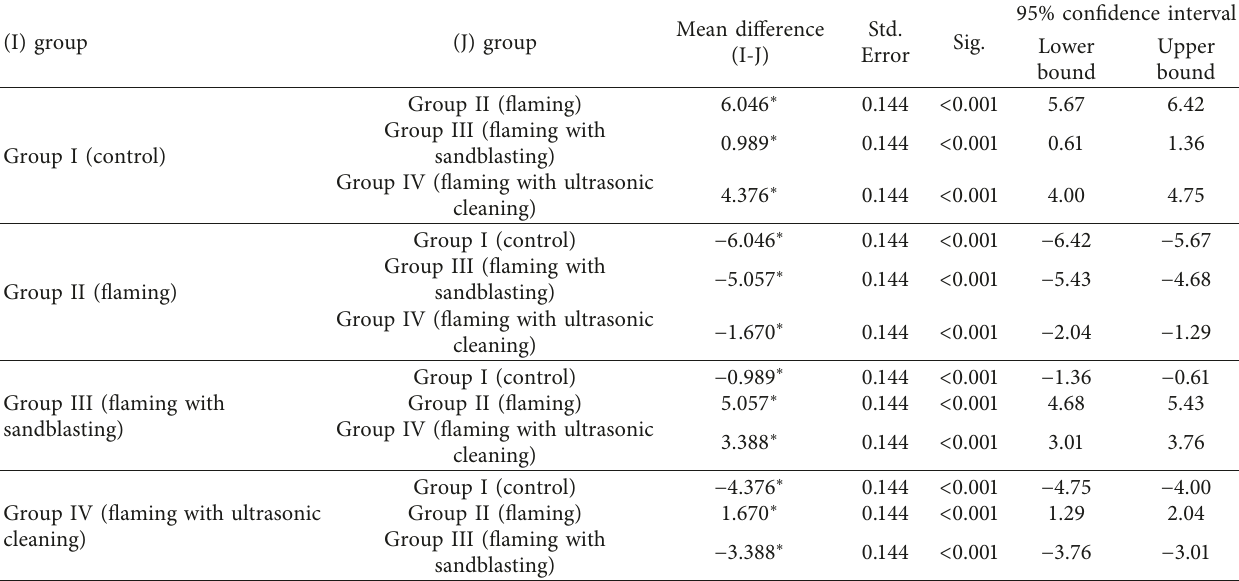
Table 3: Tukey’s post hoc multiple comparison test for intergroup